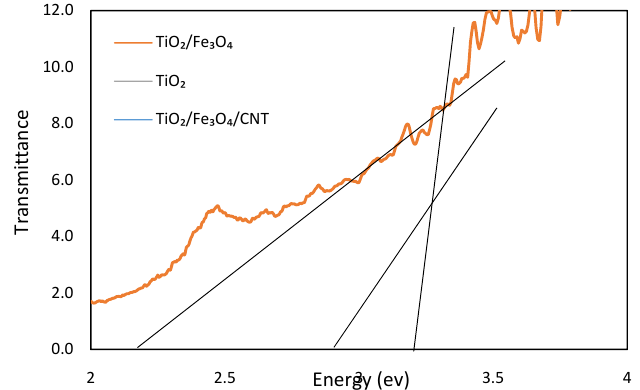
, TiO /Fe O and TiO /Fe O /MWCNT nanomaterials by DRS analysis 2 2 3 4 2 3 4 by DRS analysis